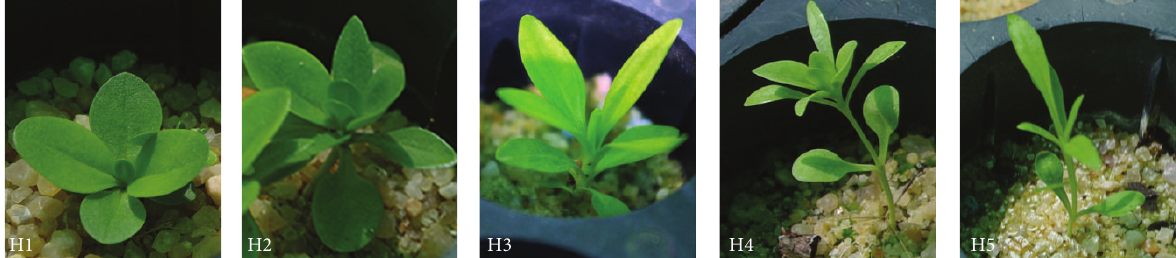
Figure 7: Growth habits (H1–H5) of Gentiana lutea var. aurantiaca seedlings on the 180th day after sowing treated seeds with GA 3 (50, 100, 500, and 1000 ppm).